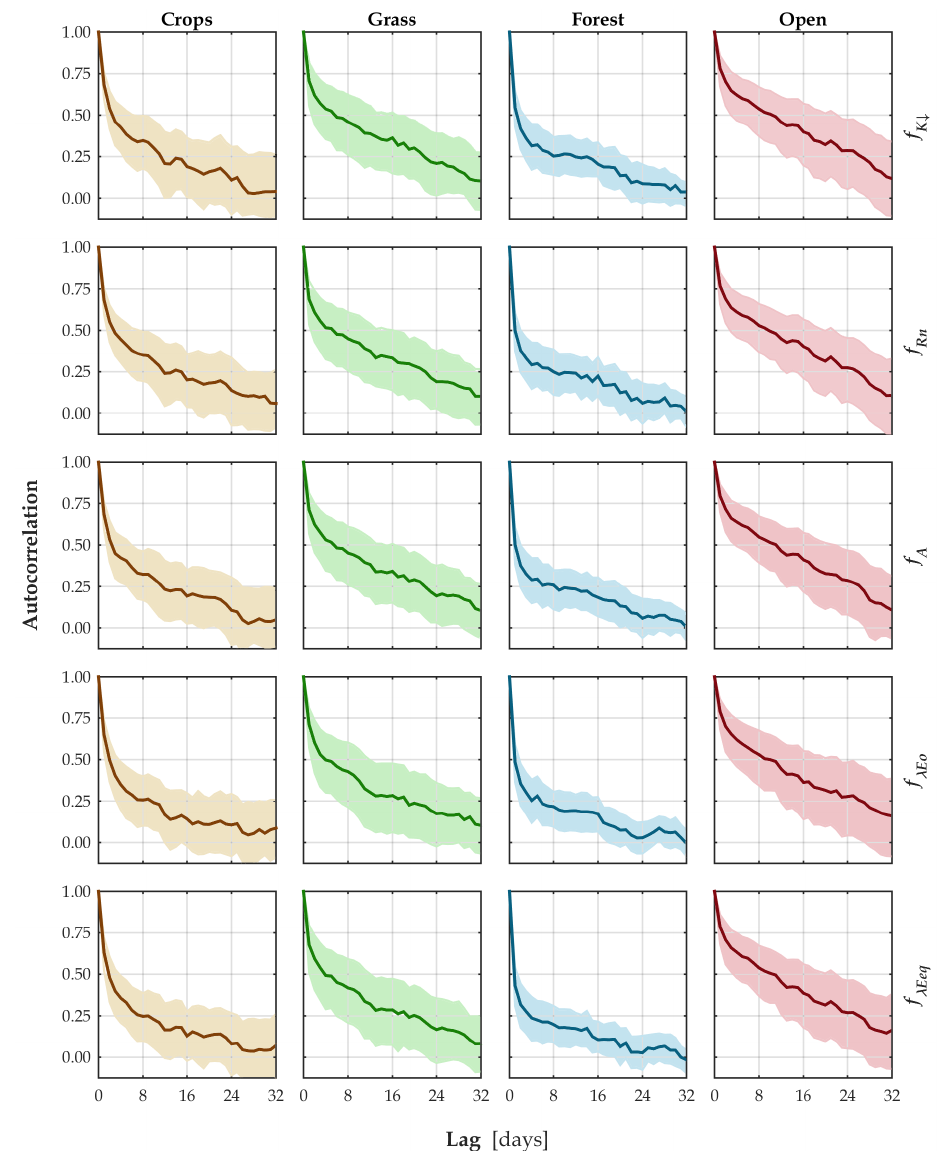
Figure 3. The representative autocorrelation function derived for each land cover type and scaled metric used in this study is shown. The shaded area represents 1 standard deviation about the